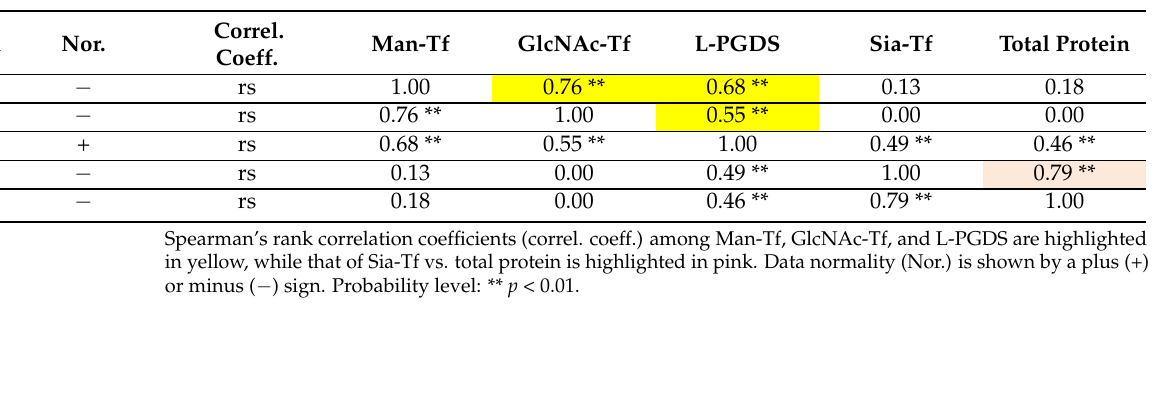
Table 2. Correlation coefficients of markers in CSF of schizophrenia